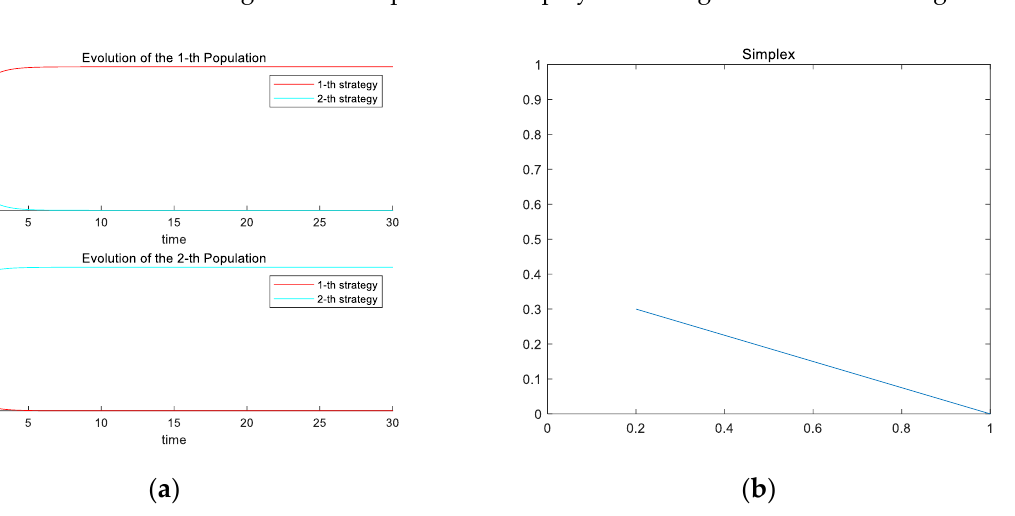
Figure 3. The strategic evolution path of the game entity when 𝜋 1 < 0, 𝜋 3 > 0 . (( a ) indicates the evolution path of the game strategy; ( b ) describes the stabilization process for a fixed point).